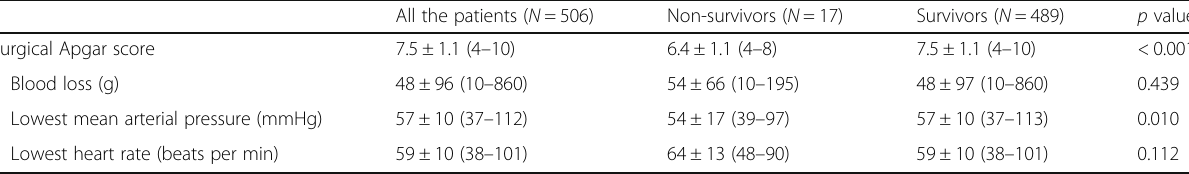
patients died of postoperative heart failure, and three patients died of sepsis. Table 4. The rate of postoperative complications was The results of our comparison of clinical characteris- 21.7% (110 of the 506 patients), and pneumonia was tics between the 97 patients in the SAS ≤ 6 group (the the most common postoperative complication (41 of high-risk group) and the 409 patients in the SAS ≥ 7 the 506 patients). The causes of 90-day mortality were group (low-risk group) are shown in Table 5. There were as follows: eight patients died of pneumonia, six Table 3 Comparison of the Surgical Apgar Score between non-survivors and survivors All the patients ( N =